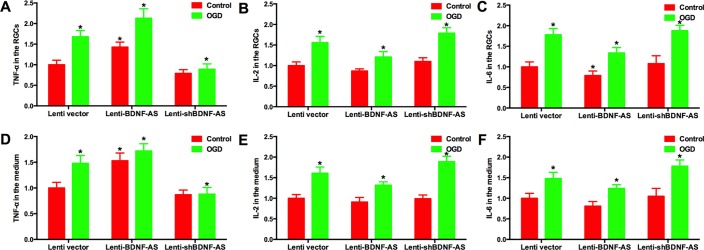
Effect of BDNF-AS on BDNF-related gene expression.RGCs were transduced with different lentiviral vectors and then exposed to OGD. The cells and medium were harvested to measure the protein levels of TNF-α, IL-2 and IL-6 using ELISA. The elevated BDNF-AS increased the levels of TNF-α while lenti-shBDNF-AS decreased the levels in the cells (A) and medium (D). The level of IL-2 in the RGCs (B) and medium (E) was lower in the lenti-BDNF-AS group compared with the lenti-shBDNF-AS group. IL-6 levels in the RGCs (C) and medium (F) were also decreased by lenti-BDNF-AS. P<0.05 was considered significantly different; * vs control group.